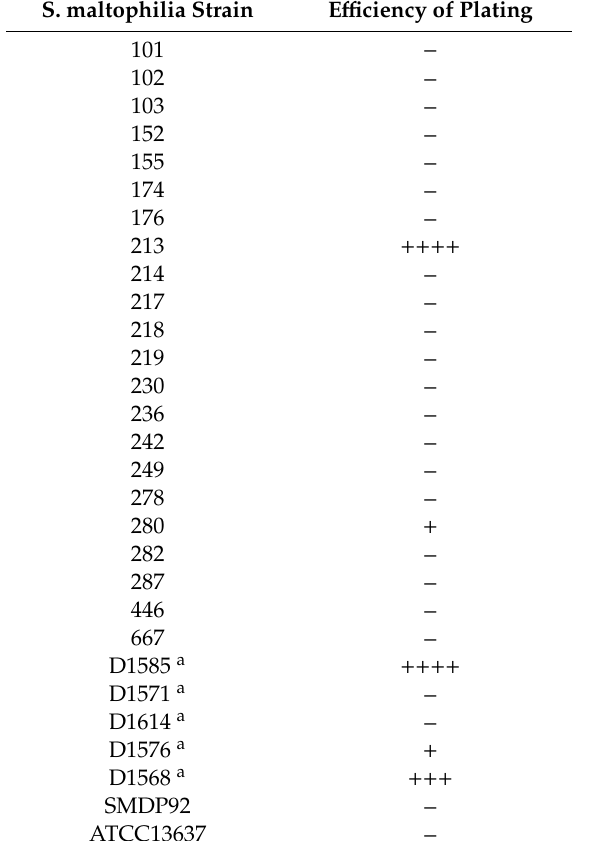
Table 1. Host range analysis of AXL3 on S. maltophilia clinical